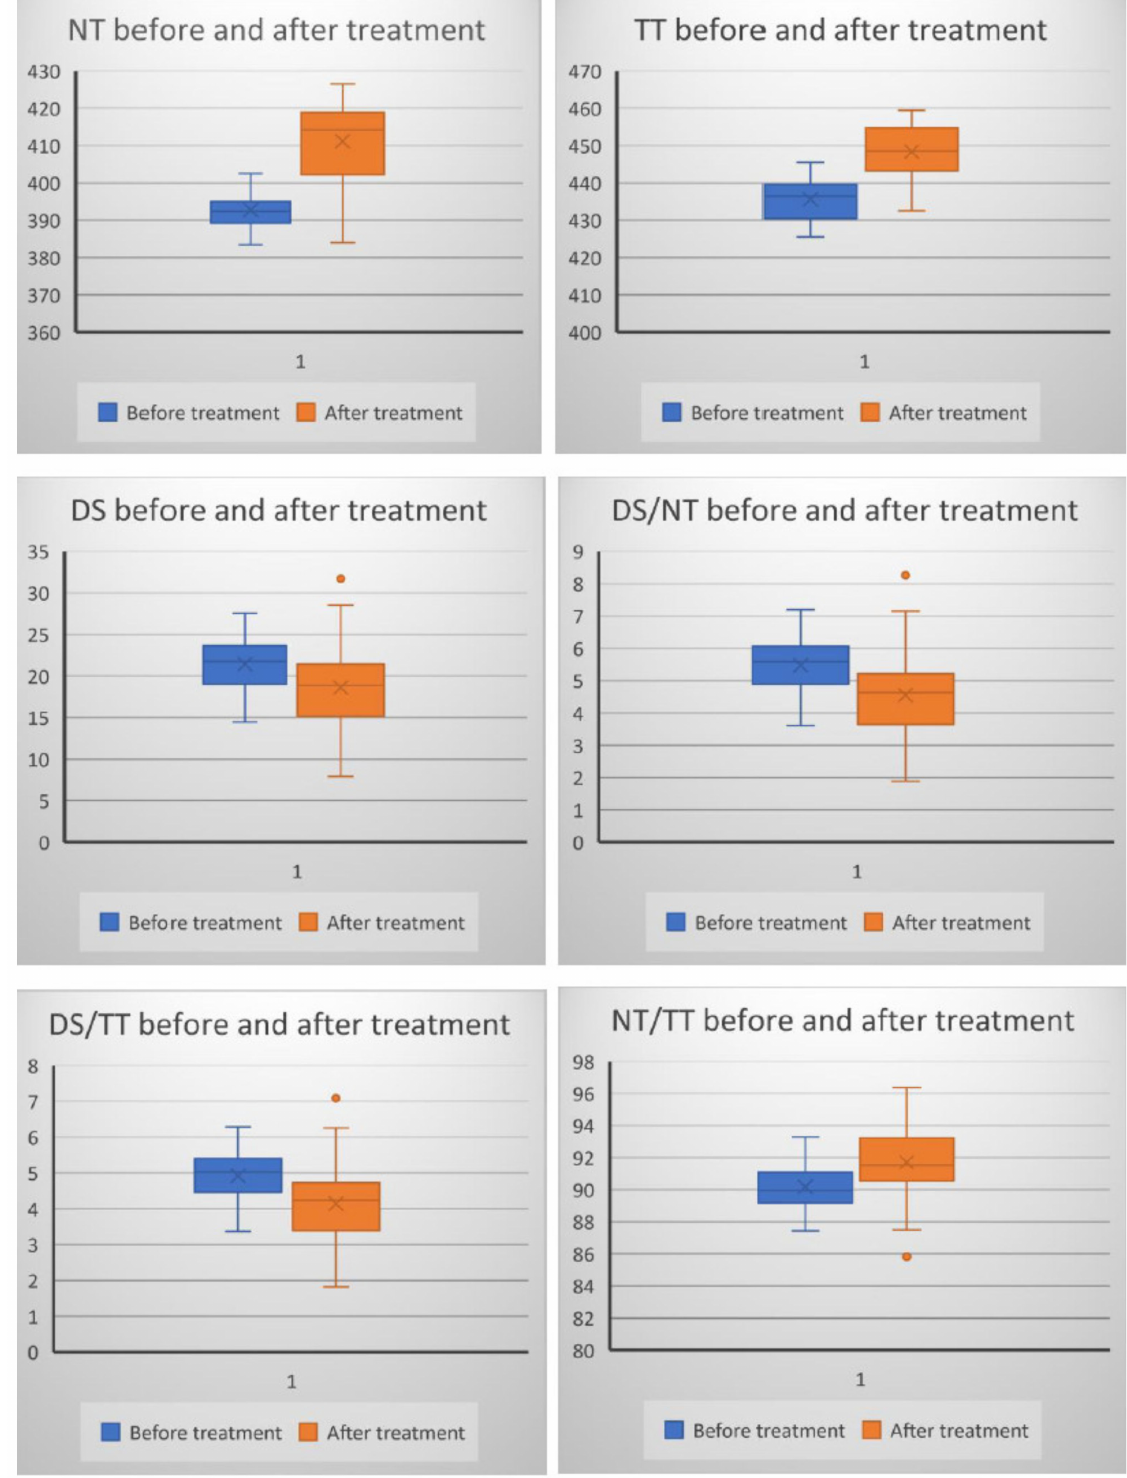
Figure 1. The evolution of TDHPs after treatment in patients with chronic spontaneous urticaria (X on the plot area represents the mean